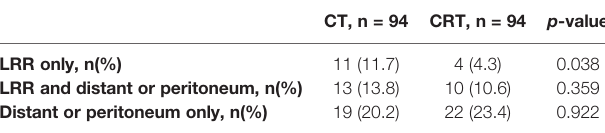
TABLE 3 | First site of recurrence in CRT and CT group.